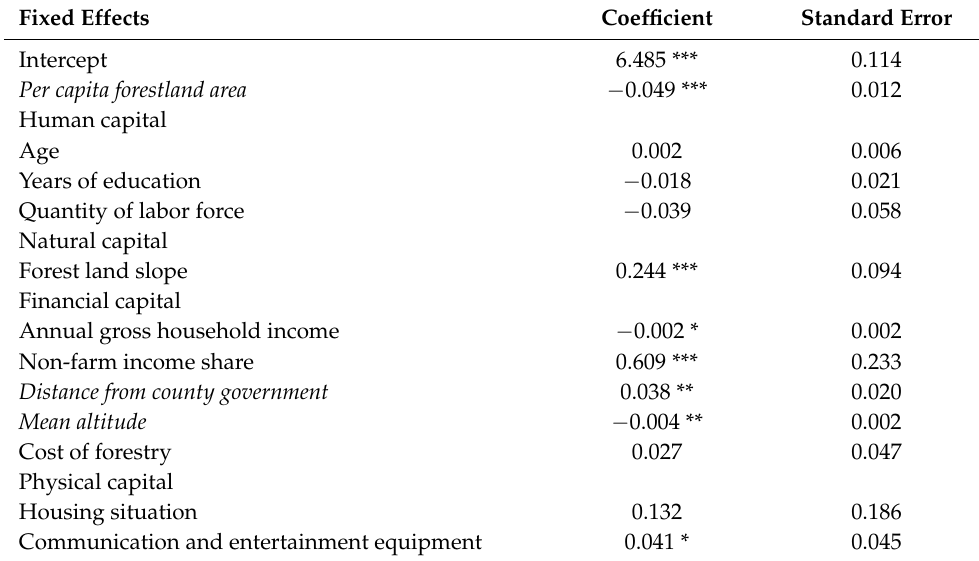
Table 5. The full model result for the economic-incentive